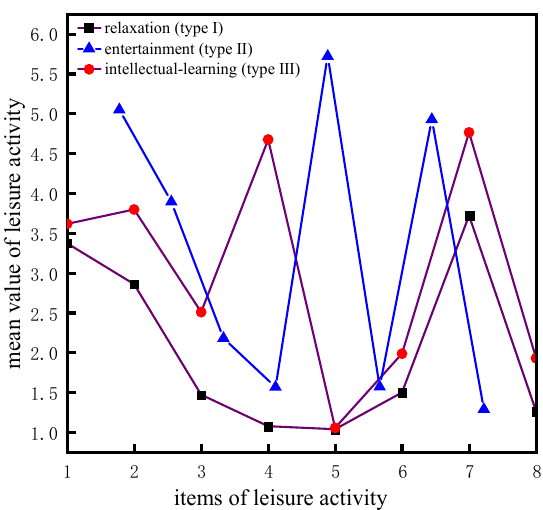
Figure 7. A latent profile analysis of leisure activities.